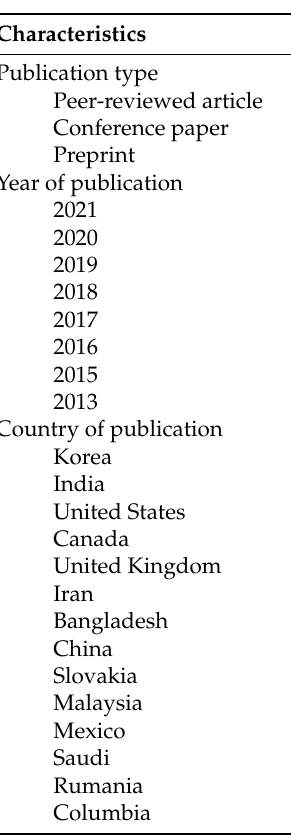
Table 1. Studies’